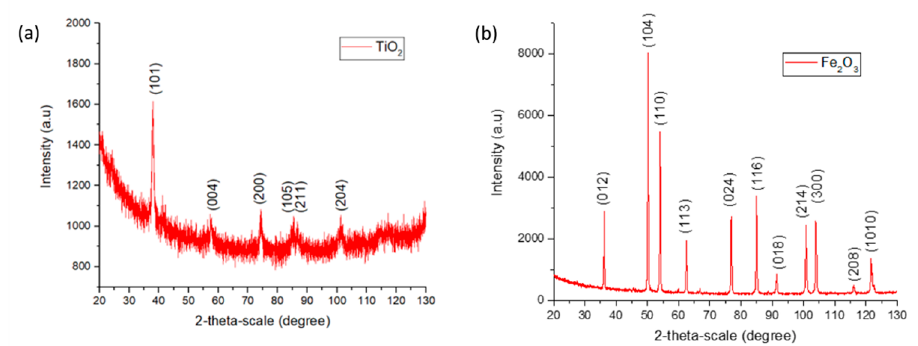
Figure 5. XRD of TiO 2 ( a ) and Fe 2 O 3 ( b ) nanoparticles.